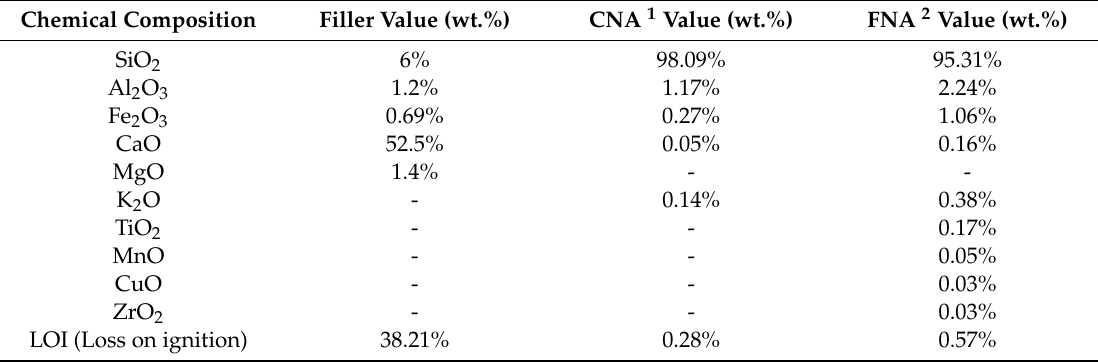
Table 2. Chemical composition: natural lime filler, coarse natural and fine natural aggregates Chemical Composition